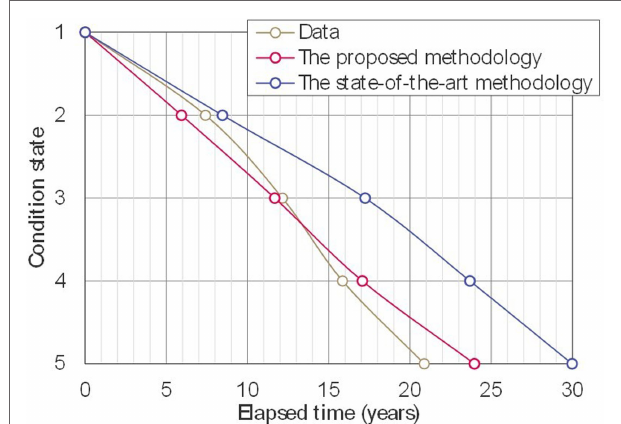
FIGURE 5 | Comparison among expected deterioration paths.